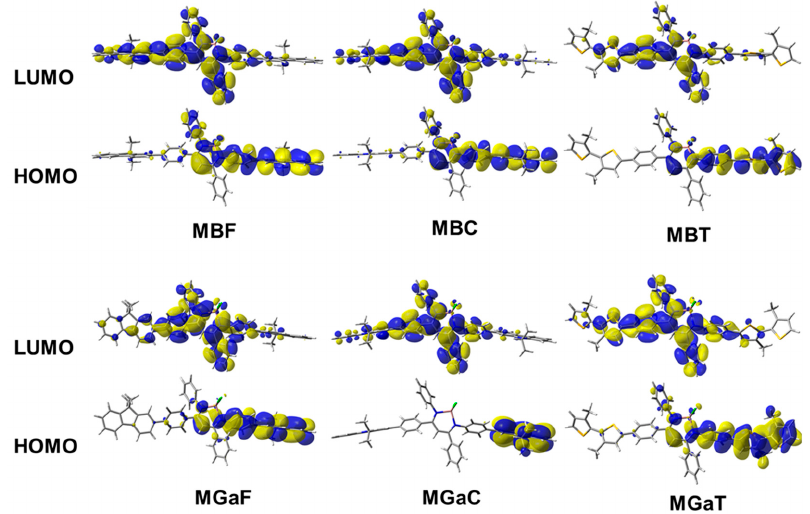
Figure 3. Frontier orbital distributions of the model compounds obtained from the DFT calculations.